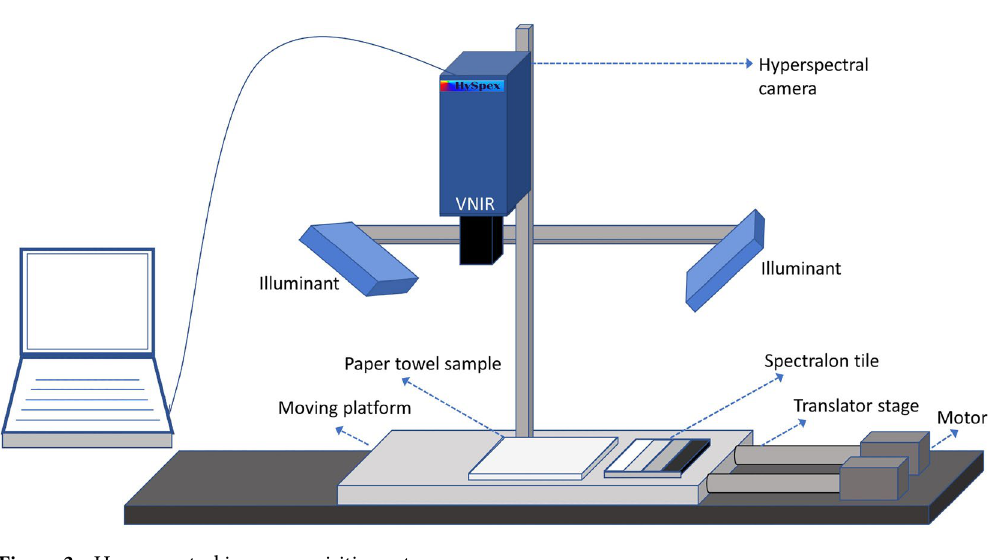
Figure 3. Hyperspectral image acquisition